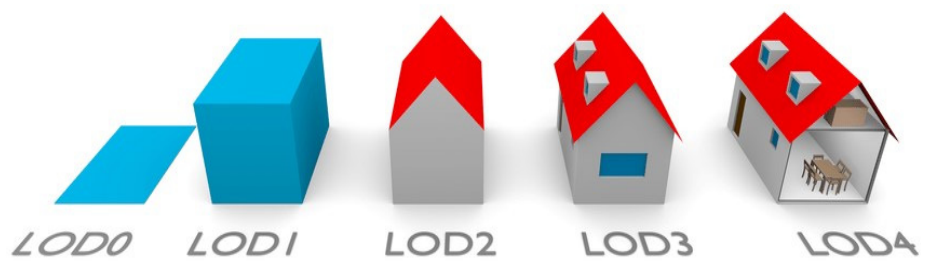
Figure 3. LiDAR 3D model swallowability level [10].